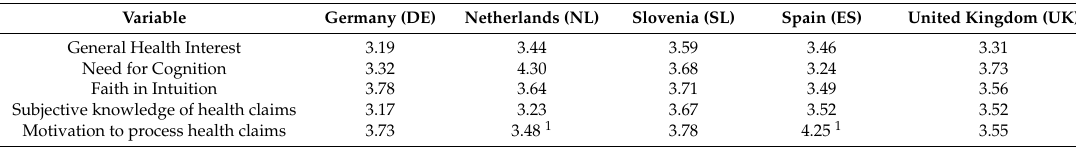
Table 4. Mean scores for background